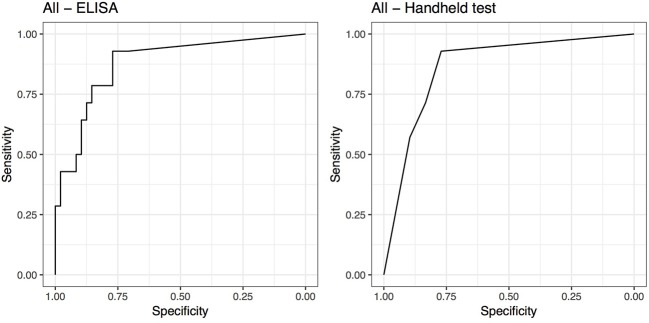
Receiver operating characteristic (ROC) curves for ELISA and handheld SAA tests for all 62 horses.